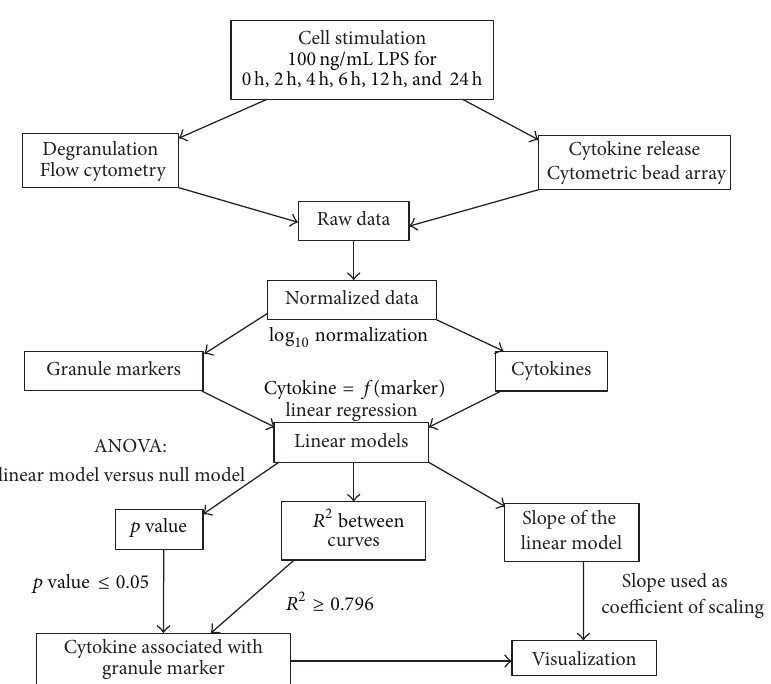
Figure 3: Workflow of linear fitting of LPS-mediated cytokine secretion and degranulation. A novel approach based on linear fitting was used to find linear relationship between short-time series of secreted cytokines and similar pattern to degranulation markers present at the plasma membrane. After importing data into R statistical software, all ratio values between LPS-stimulated and nonstimulated control conditions were log 10 normalized and treated as mentioned in Section